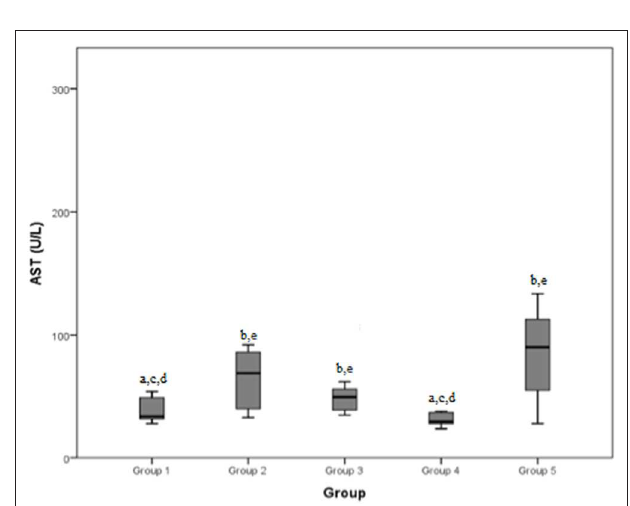
FIGURE 3 | Lymphocytes (normal range: 1000–4800/mm 3 ) differences between the five examined groups. Statistically significant differences are indicated as follows: (d) significantly different from group 2; (e) significantly different from group 1.